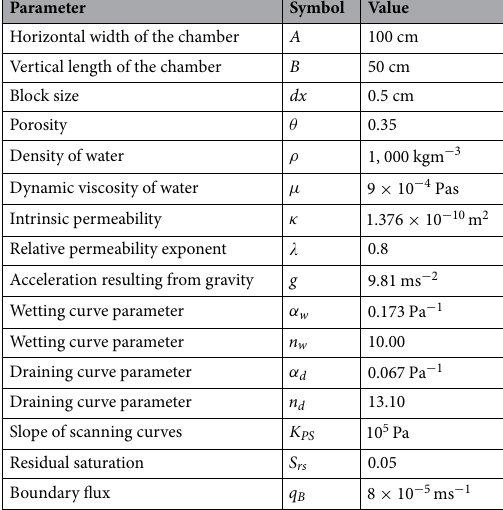
Table 1. Parameters used for reproducing the wetting front instability experiments. The parameters for 30/40 sand were adopted from Schroth et al. 59 and DiCarlo 25